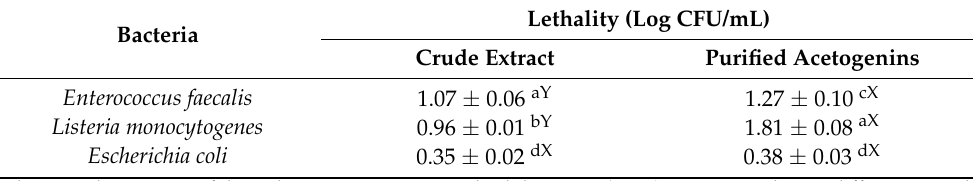
Table 4. Lethal effect of crude extract and purified acetogenins on Enterococcus faecalis , Listeria monocytogenes, and Escherichia coli . Lethality (Log CFU/mL) Bacteria Crude Extract Purified Acetogenins Enterococcus faecalis Listeria monocytogenes 0.96 ± 0.01